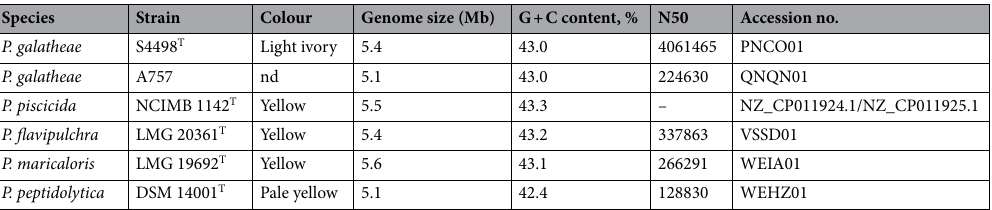
Table 1. Genomic data on Pseudoalteromonas strains included in type strain comparisons. Nd no data.